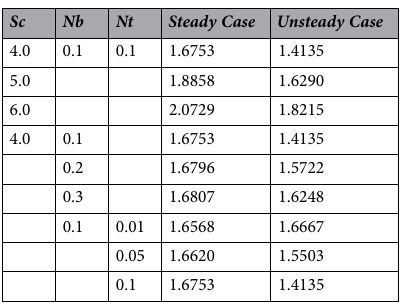
Table 6. Results of Sherwood number – φ ′ ( 0 ) for various